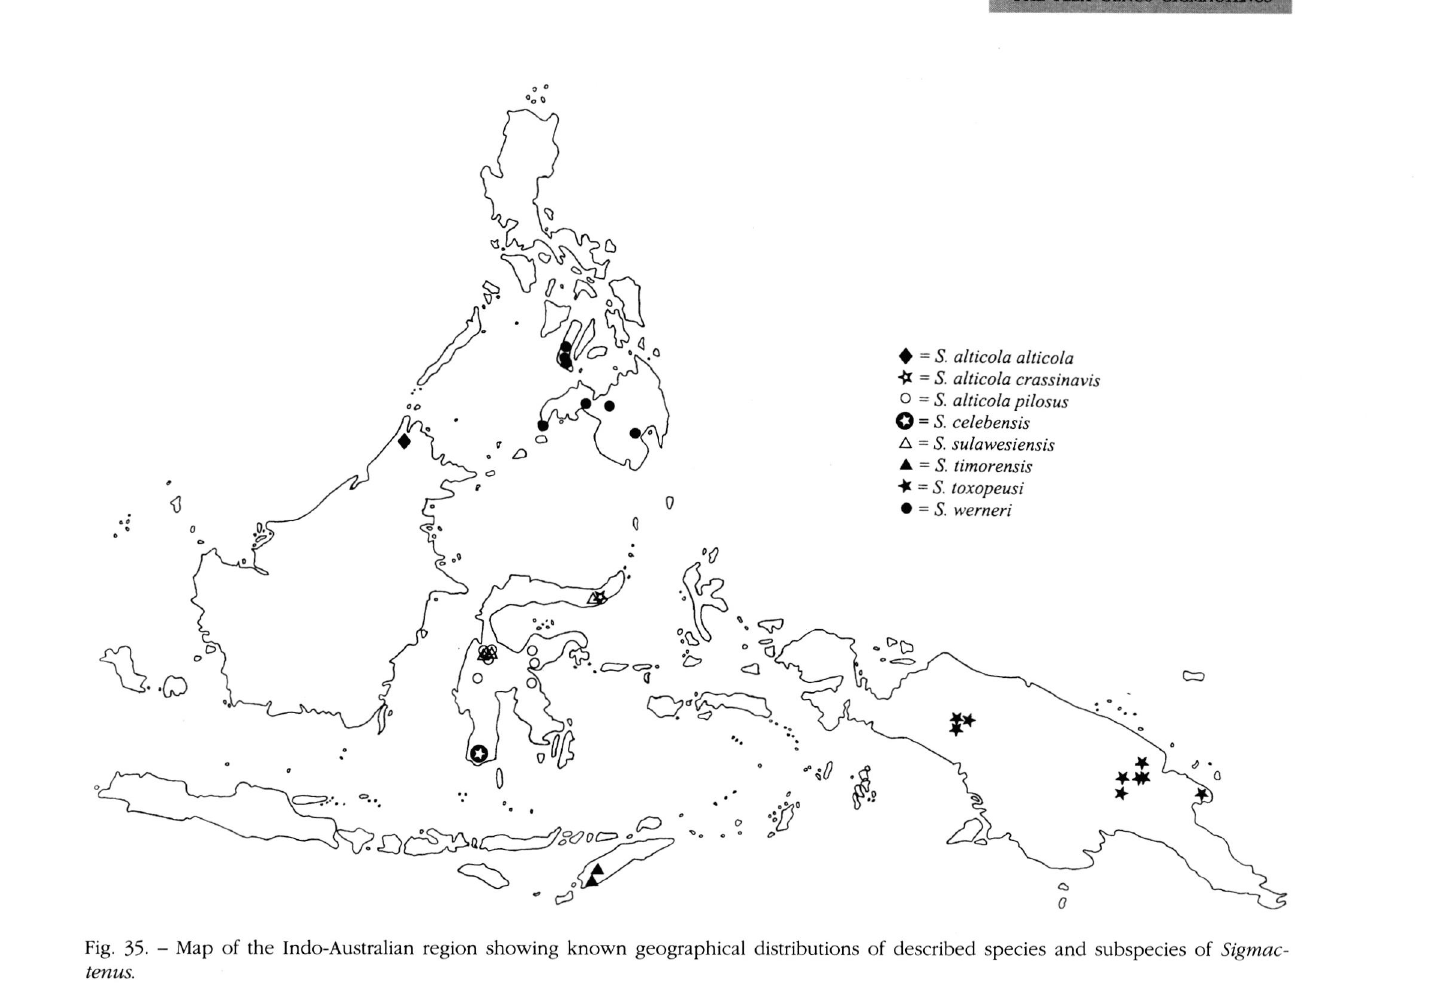
Fig. 35. - Map of the Indo-Australian region showing known geographical distributions of described species and subspecies of Sigmac-